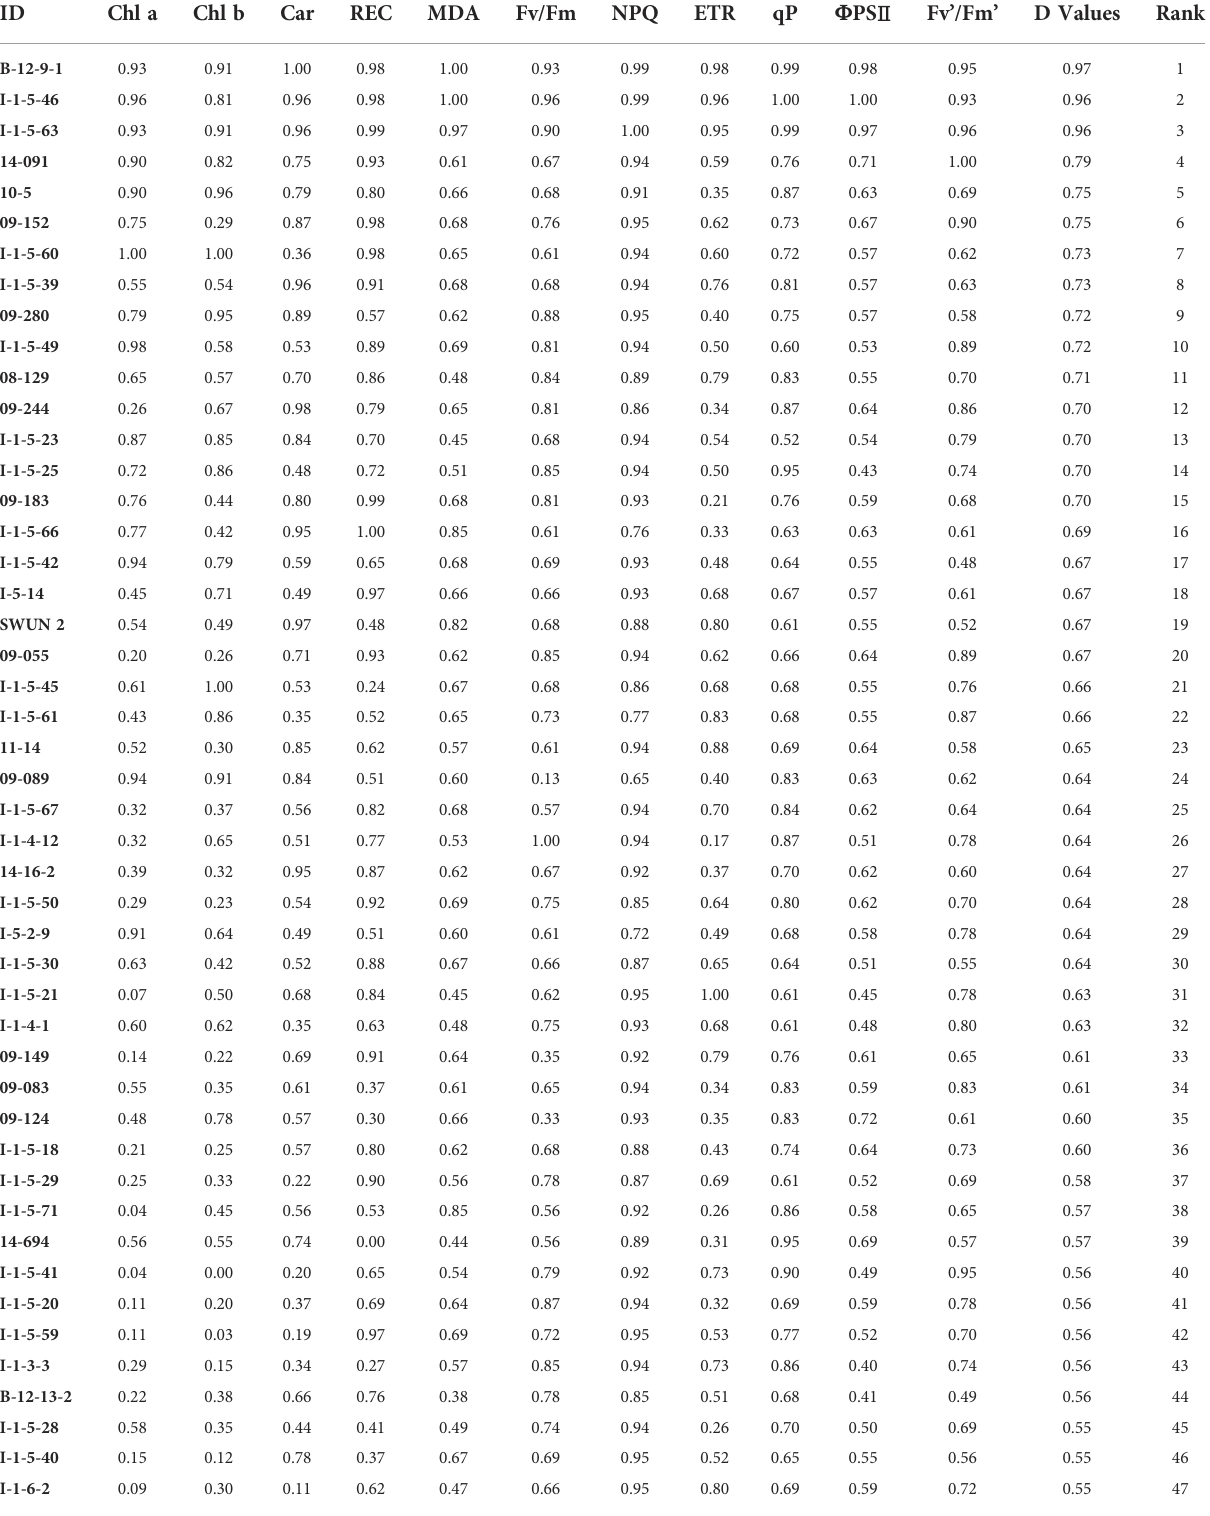
TABLE 2 Comprehensive evaluation through subordinate functions of 52 Elymus sibiricus genotypes. Subordinate function